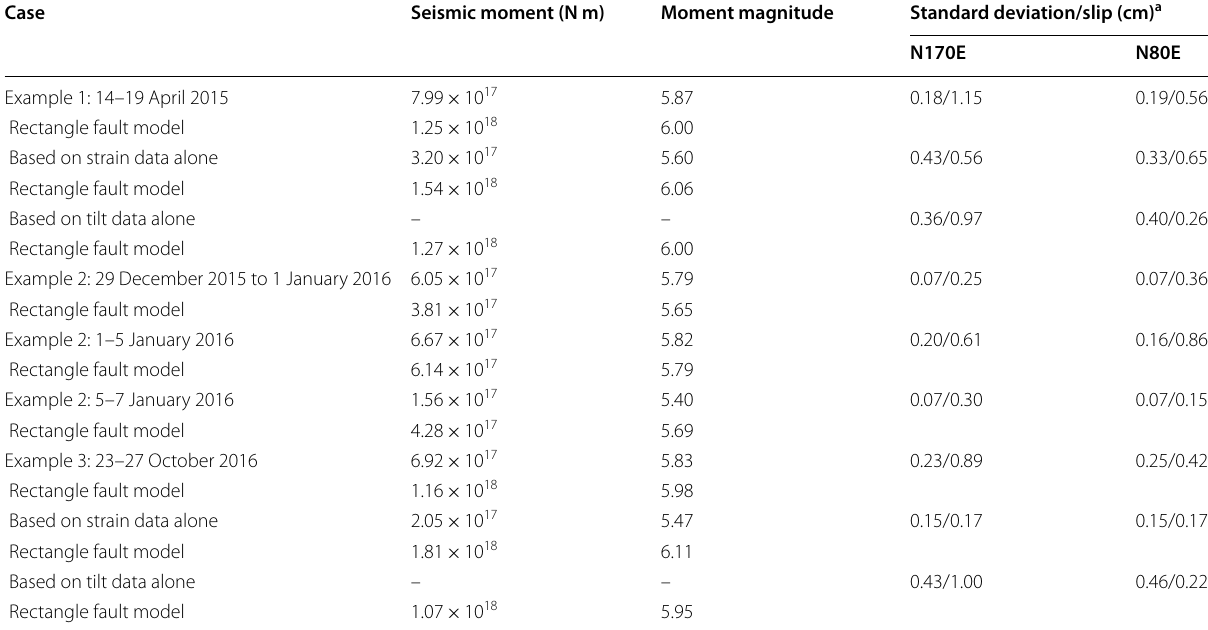
Table 2 Inversion results for each